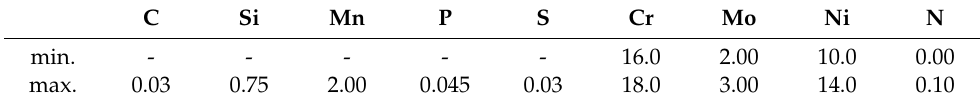
Table 1. Alloy range in mass% permitted according to ASTM A276 for the steel AISI 316L [16]. C Si